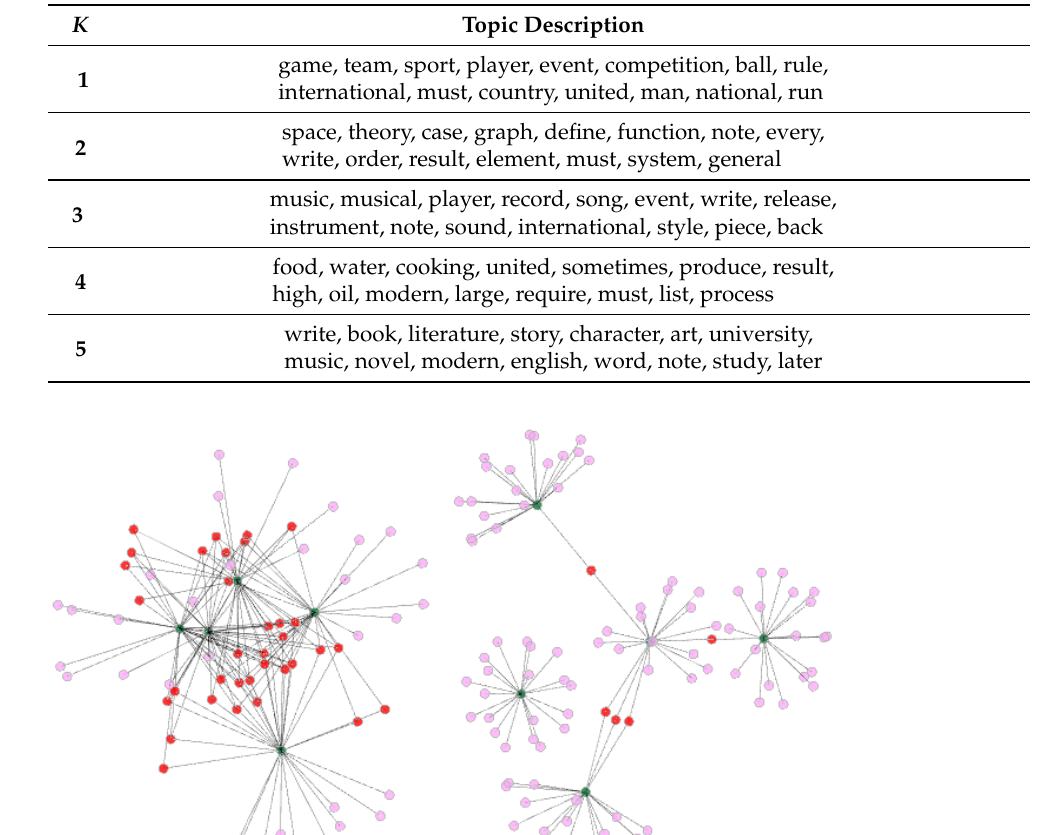
Table 18. D1 topic–terms representation, Boolean-TF weighting scheme, K = 5, probabilistic modeling.